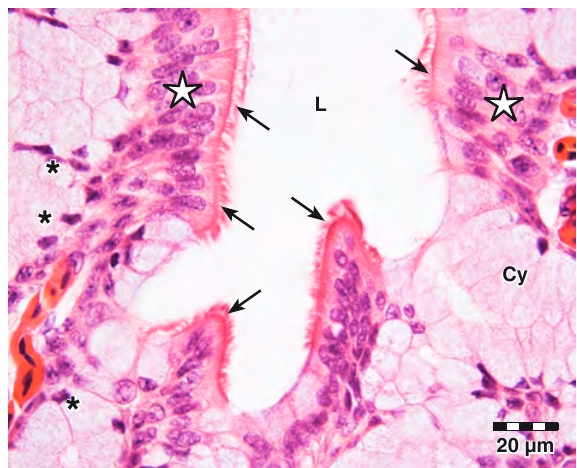
FIG. 3 The non­keratinized stratified squamous epithelium of the tongue dorsum displaying the Str. basale (Sb) with melanocytes ( * ) some of which lie in the connective tissue beneath the Str. basale , Str. spinosum (Ss) and Str. corneum (Sc). Connective tissue (Ct), connective tissue papilla (P), capillary (arrows)